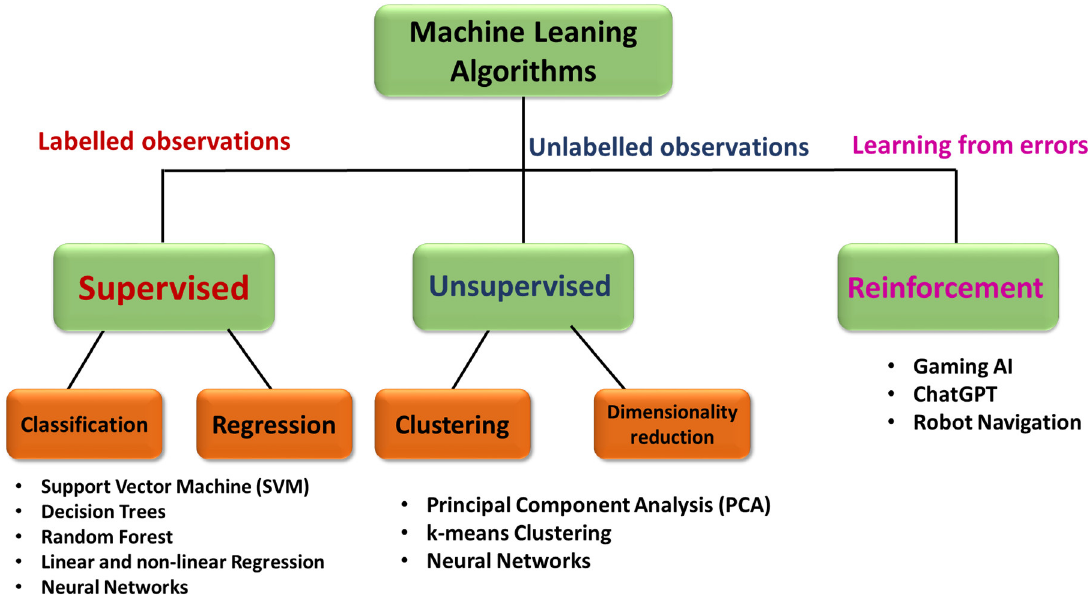
Figure 6. Flow chart illustrating the classification of different machine learning algorithms as supervised, unsupervised, and reinforcement models.